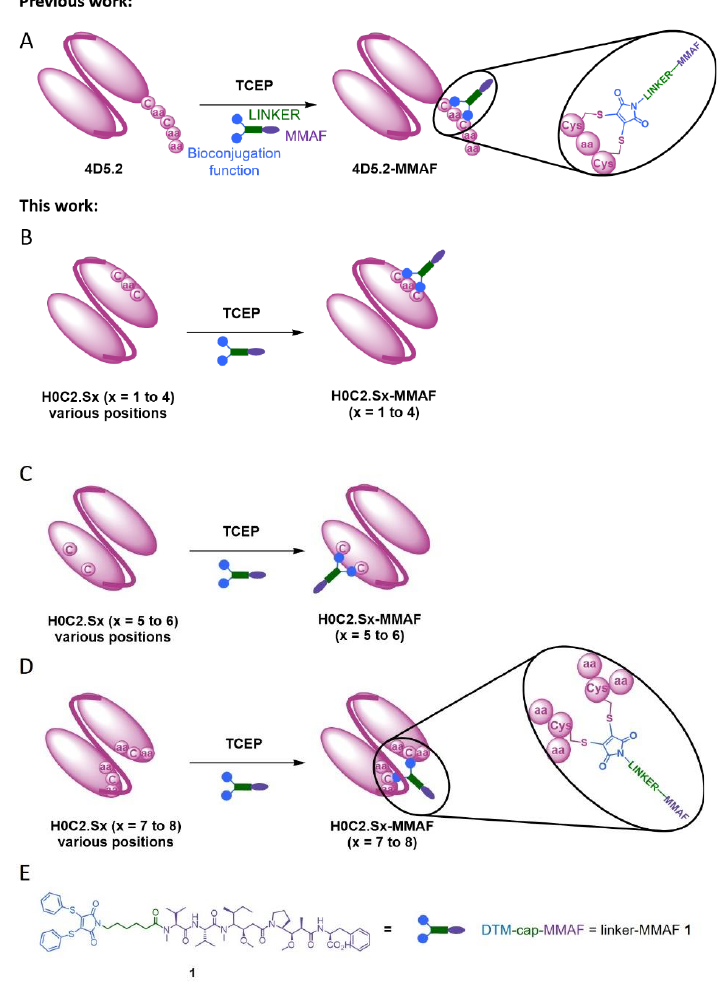
Figure 1. ( A ) Intra-tag cysteine (ITC) strategy: site-specific antibody fragment – drug conjugate (FDC) 4D5.2-MMAF with a drug-to-antibody ratio (DAR) of 1, resulting from the reduction of the single disulfide bridge of 4D5.2 at the C-terminal (and the reduction of 4D5.2 dimer form) with TCEP and conjugation of linker-MMAF 1 , including monomethyl auristatin F (MMAF). ( B ) Linear intra-domain cysteine (IDC) strategy: site-specific FDC H0C2.Sx-MMAF (x = 1 to 4) with a DAR of 1, resulting from the reduction of a single supplementary intra-domain disulfide bridge (the two cysteines are separated only by one amino acid) of H0C2.Sx (and the reduction of H0C2-Sx dimer form) with TCEP and conjugation of linker-MMAF 1 . ( C ) Conformational IDC strategy: site-specific FDC H0C2.Sx-MMAF (x = 5 to 6) with a DAR of 1, resulting from the reduction of the single intra-domain disulfide bridge (the two cysteines are separated by several amino acids on the same variable domain) of H0C2.Sx (and the reduction of H0C2.Sx dimer form) with TCEP and conjugation of linker-MMAF 1 . ( D ) Conformational IDC strategy: site-specific FDC H0C2.Sx-MMAF (x = 7 to 8) with a DAR of 1, resulting from the reduction of the single inter-domain disulfide bridge (the two cysteines are each on a different variable domain) of H0C2.Sx (and the reduction of H0C2-Sx dimer form) with TCEP and conjugation of linker-MMAF 1 . ( E ) Chemical structure of non-cleavable linker-MMAF 1